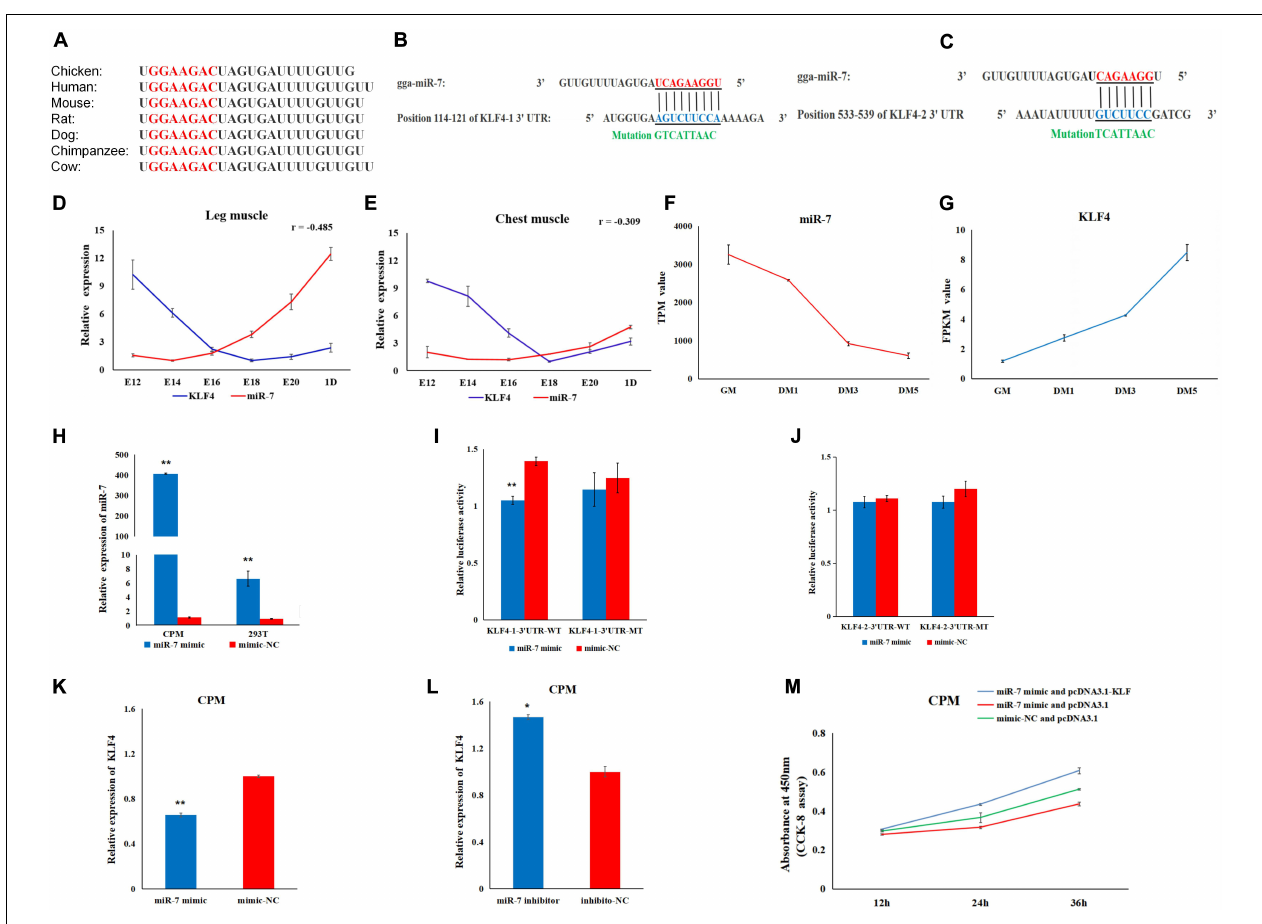
FIGURE 4 | KLF4 is a target gene of miR-7. (A) The seed sequence of miR-7 is highly conserved among vertebrates. (B,C) The potential binding sites for miR-7 in the 3 (cid:48) untranslated region (3 (cid:48) UTR) of KLF4 (KLF4-1 3 (cid:48) UTR and KLF4-2 3 (cid:48) UTR). (D,E) The expression trends of miR-7 and the KLF4 gene in chest and leg muscles. E12, E14, E16, E18, E20, and 1D represent 12, 14, 16, 18, 20 embryonic days and 1-day-old of Jinghai Yellow chickens, respectively. (F,G) The expression levels of miR-7 and the KLF4 gene during proliferation and differentiation stages using RNA-seq data. GM represents CPMs in the proliferation stage (100% confluence). DM1, DM3, and DM5 represent CPMs which were induced to differentiate for 24, 72 and 120 h, respectively. TPM is the abbreviation of Transcripts Per Million, and FPKM is the abbreviation of Fragments Per Kilobase per Million (H) Overexpression efficiency 48 h after transfection of the miR-7 mimic in CPMs and 293T cells. (I,J) Luciferase assays were performed by co-transfection of wild-type or mutant KLF4 3 (cid:48) UTR with a miR-7 mimic or mimic-NC. (K,L) The mRNA expression level of KLF4 were detected 48 h after being transfected with the miR-7 mimic or inhibitor in CPMs. (M) The results of the rescue experiment in CPMs using CCK-8 assay. The results are shown as the mean ± SEM of three independent experiments, * p < 0.05, ** p <